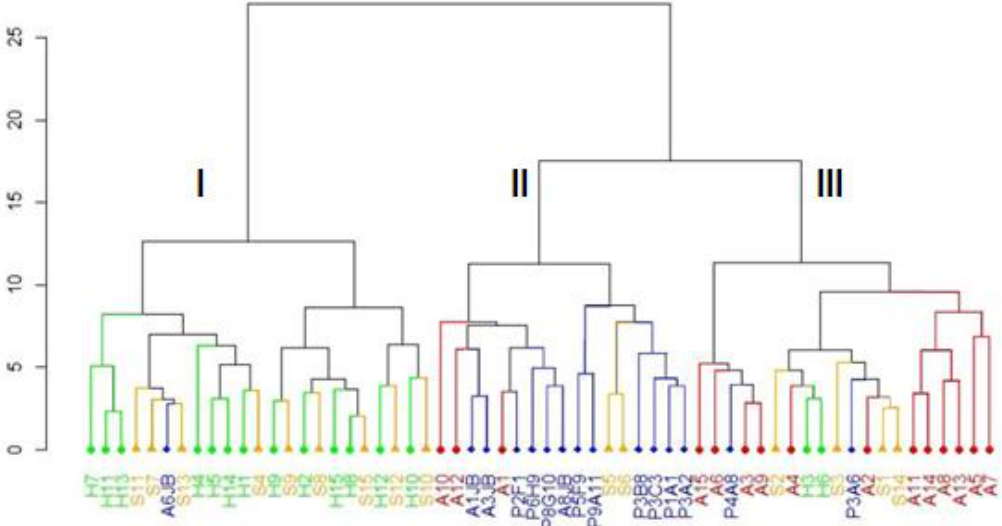
Figure 3. Dendrogram constructed by Euclidean distance using Ward’s method, to study the relationships among the 60 argan trees based on quantitative traits.